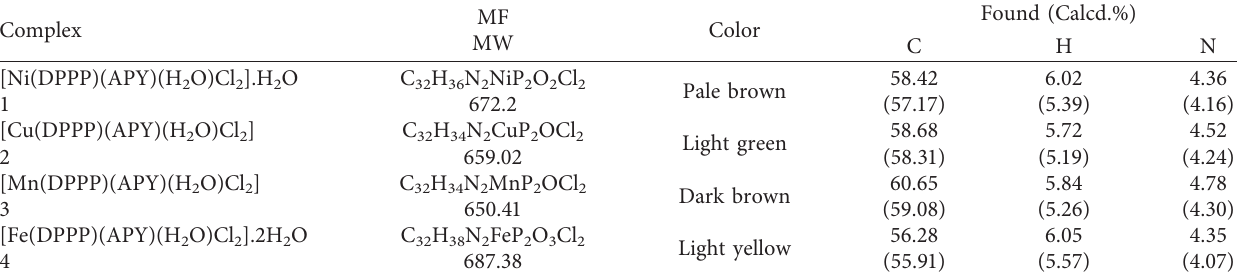
Table 1: Color, elemental analysis, and decomposition point of the mixed ligand complexes.